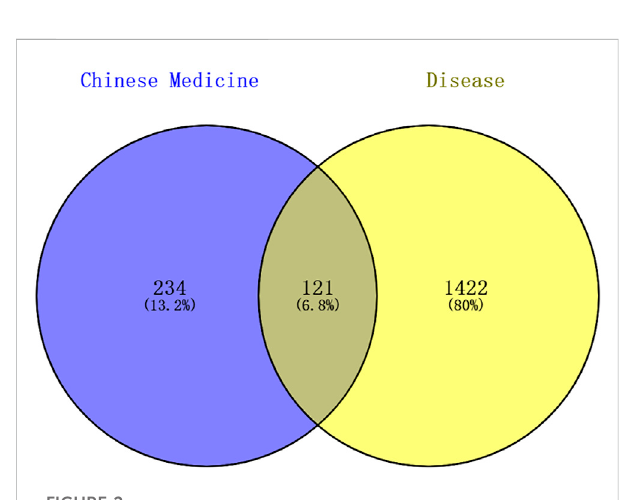
FIGURE 2 Venn diagram of Chinese medicine and disease targets. The shaded areas are the intersection targets of Chinese medicine and